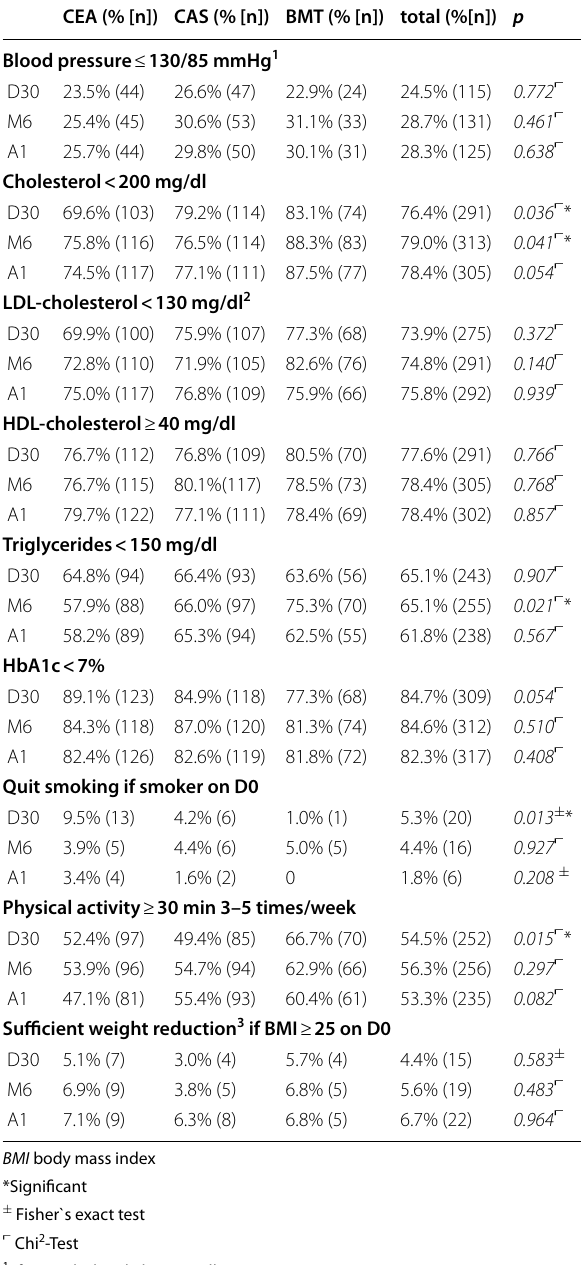
Table 1 Proportion of patients with sufficient implementation of BMT goals; visit D30 to A1; n =